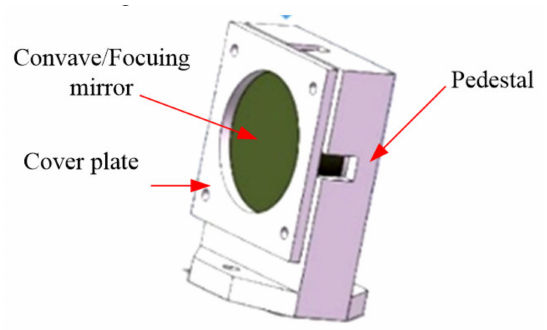
Figure 17. The components of the concave reflecting